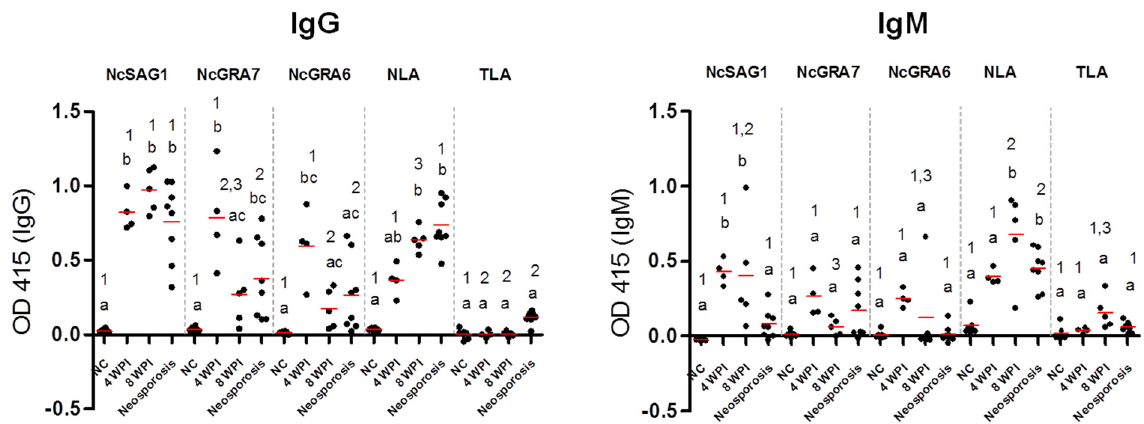
Figure 5. Enzyme-linked immunosorbent assay (ELISA) results against experimental and control cattle sera. Reactivity of ELISAs sensitized by recombinant and lysate antigens (NcSAG1, NcGRA7, NcGRA6, and NLA) were tested against cattle sera using the IgG-ELISA (left panel) and IgM ELISA (right panel). Sera from non-infected ( n = 6) and N. caninum -experimentally infected cattle sera at 4 weeks post-infection (wpi) ( n = 4), 8 wpi ( n = 8), and naturally infected cattle sera termed as neosporosis confirmed by immunohistochemistry ( n = 8). The same sera were tested against T. gondii lysate (TLA) to assay the cross-reactivity. Each bar represents the mean ± standard deviation. The different letters above the bars in the graphs indicate statistically significant differences of different sera against the same tested antigen. The different numbers above the bars indicate the statistically significant differences for the same serum sample against different tested antigens (one-way ANOVA with Tukey–Kramer post hoc analysis, p < 0.05).